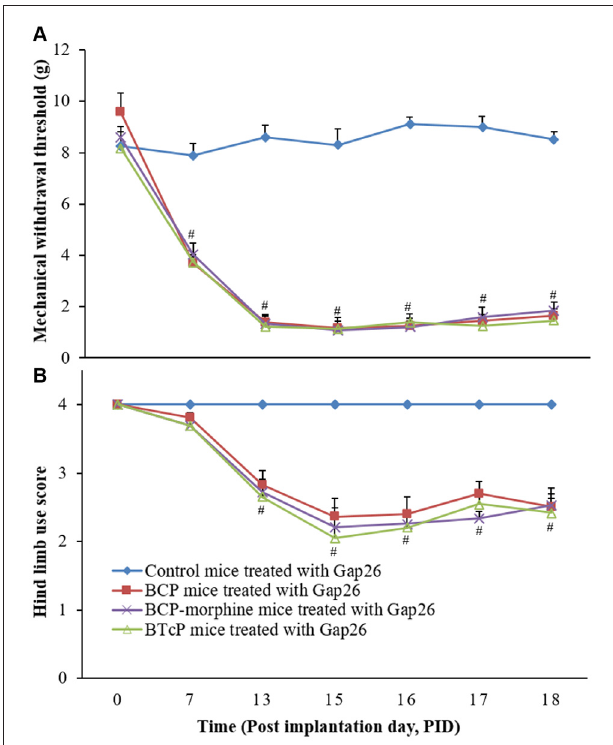
FIGURE 3 | Effects of Gap26 on the PWMT of left hind paw (A) and hind limb use score (B) in normal, BCP, BCP-morphine and BTcP mice. Gap 26 was administrated by intrathecal injection at 5 mg/kg/day, once a day for 3 days (post-implantation days, PIDs 16–18). The tests of the PWMT of left hind paw and hind limb use score in mice were performed at 8 am. Five mice were used for each group. # P < 0.05, BCP, BCP-morphine or BTcP mice vs. control